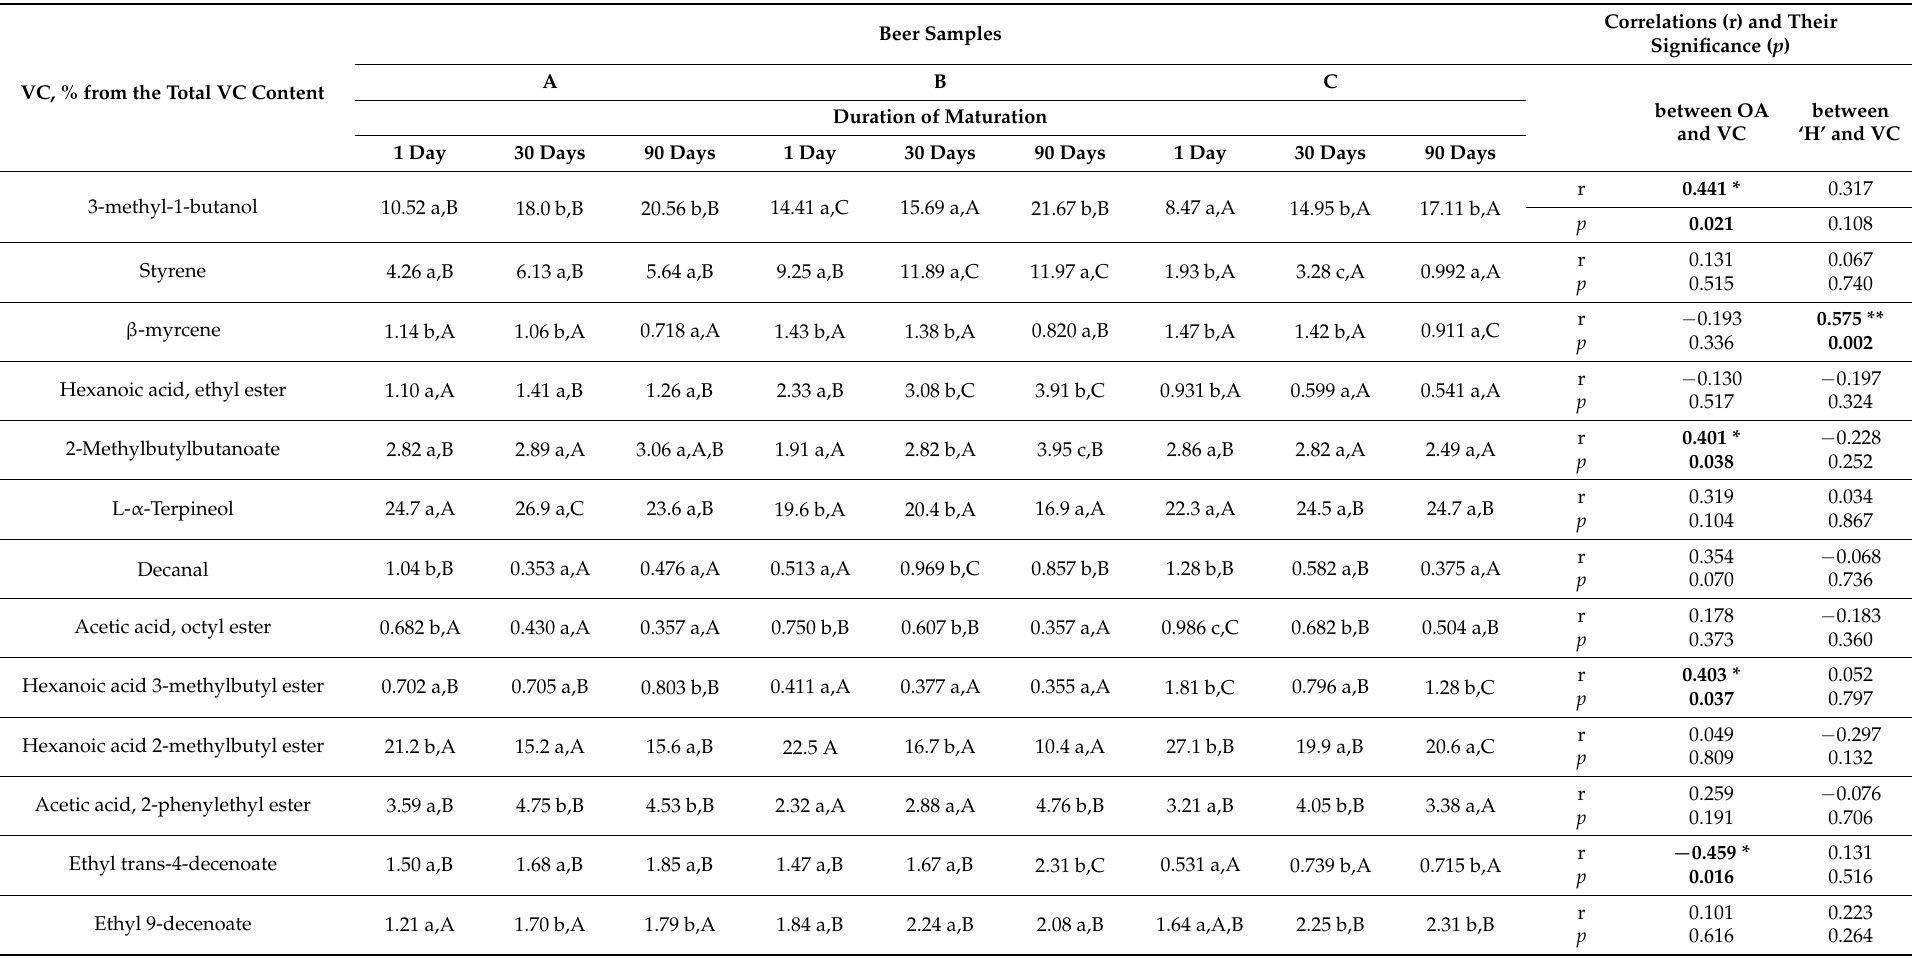
Table 4. The main volatile compounds of the beer samples (A—beer fermented with Saccharomyces cerevisiae var. diastaticus ; B—beer fermented with Saccharomyces cerevisiae var. bayanus ; C—beer fermented with Brettanomyces claussenii